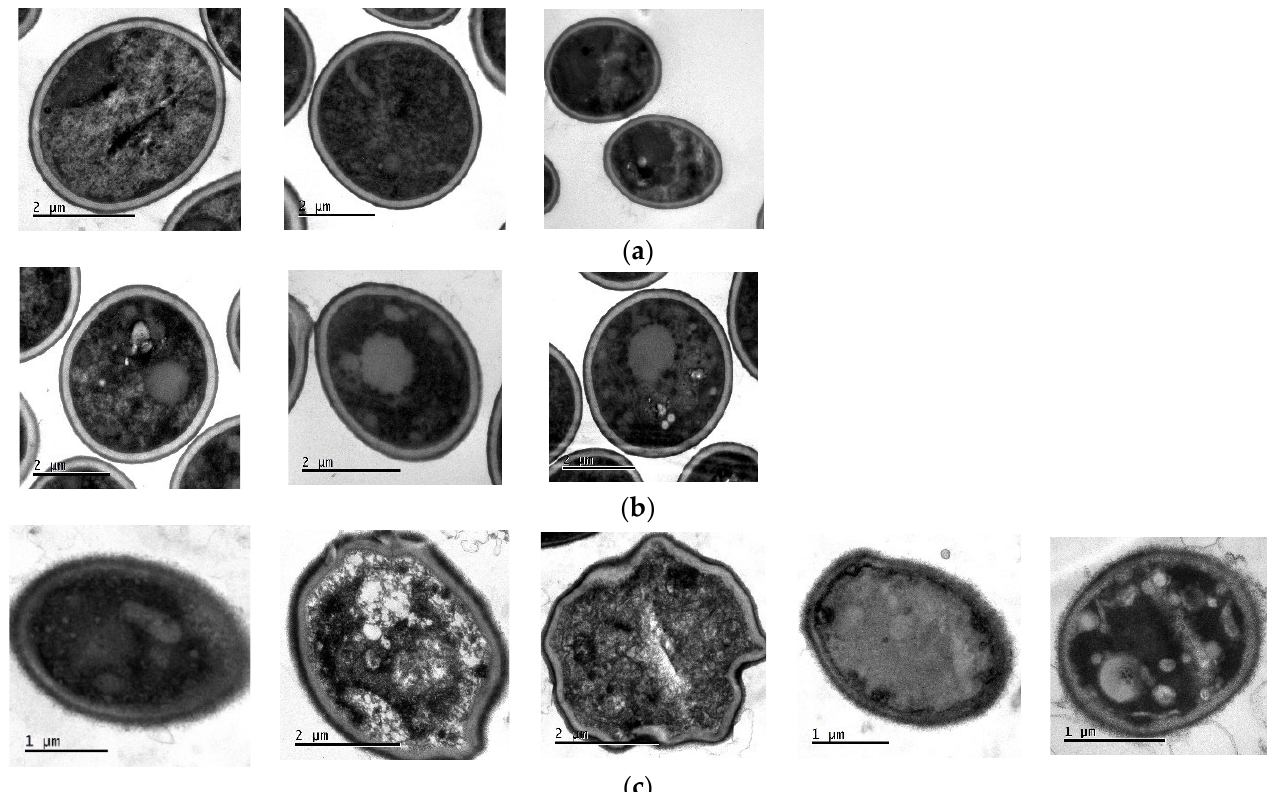
Figure 10. TEM of C. tropicalis untreated ( a ), treated with FLZ ( b ) and treated with ISO ( c ). The evident change in the morphology of the cells treated with ISO, as well as the damage to the integrity of the fungal cell membrane, is observed.